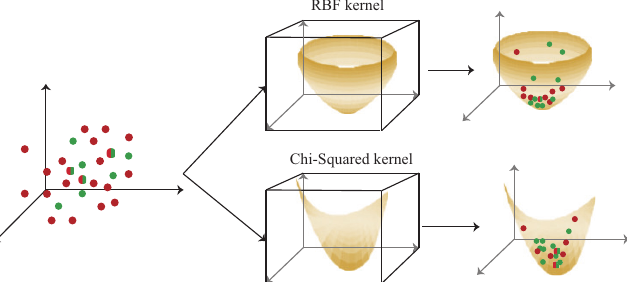
Figure 2. The comparison with RBF kernel and chi-squared